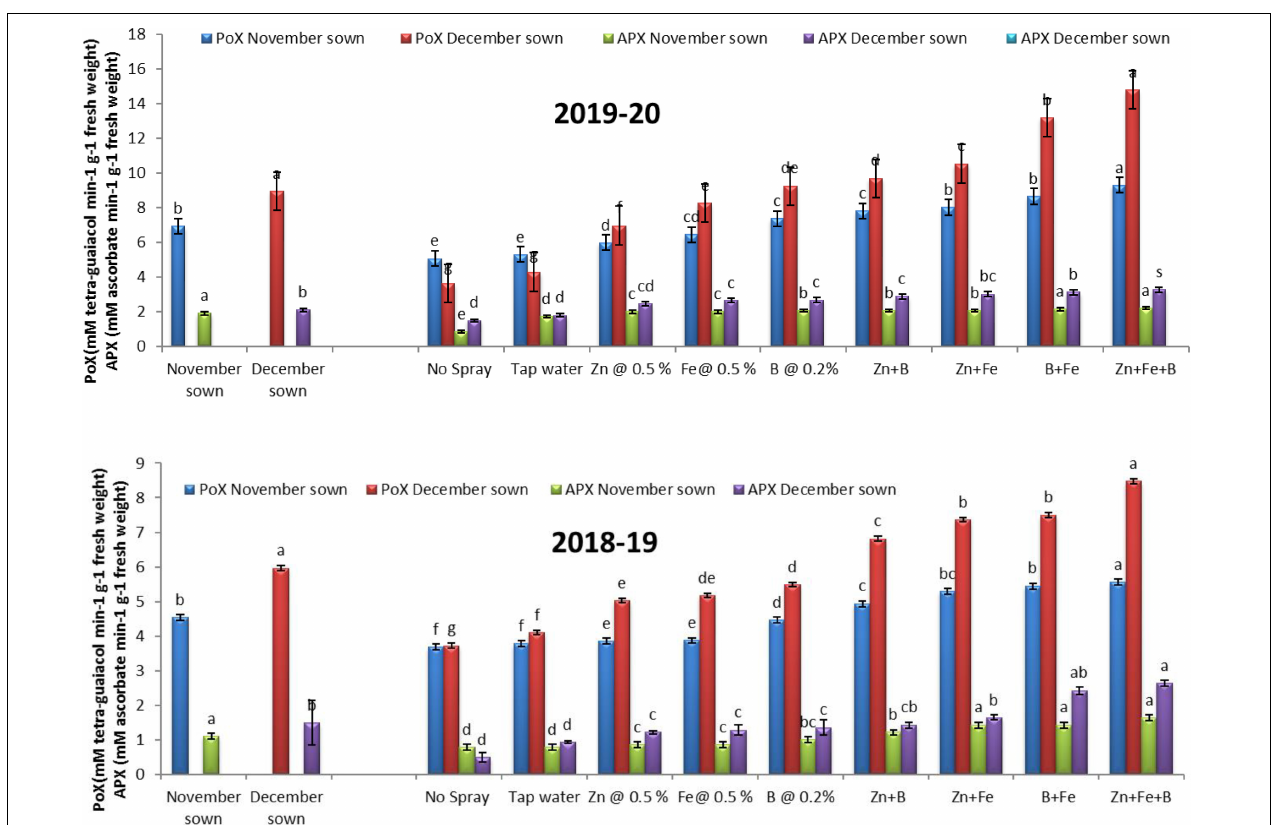
FIGURE 7 | Peroxidase (POX; mM tetra-guaiacol min - 1 g - 1 FW) and ascorbate peroxidase (APX; mM ascorbate min - 1 g - 1 FW) activities for different sowing dates and foliar spray treatments in 2018–19 and 2019–20 lentil cropping seasons. Values are means, and bars represent ± SEM ( n = 3). Different letters indicate significant differences between